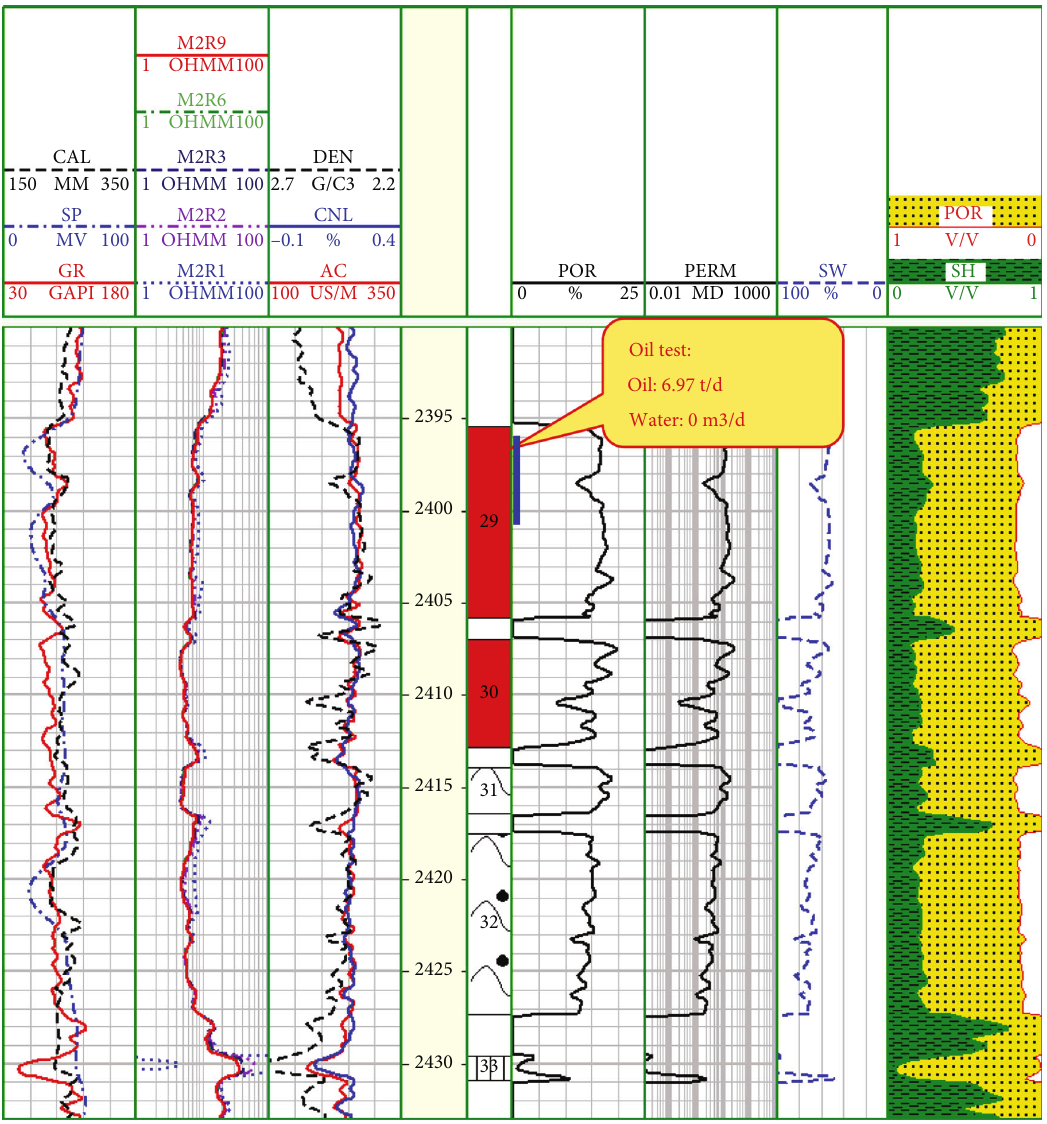
Figure 14: Well logs, oil test, and predicted results of Well